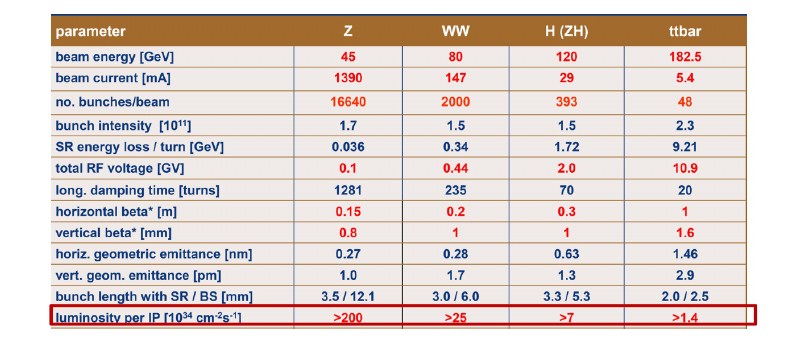
Figure 2. The most relevant parameters of projects of circular colliders [8] (the numbers referring to the FCC-ee are given as example).